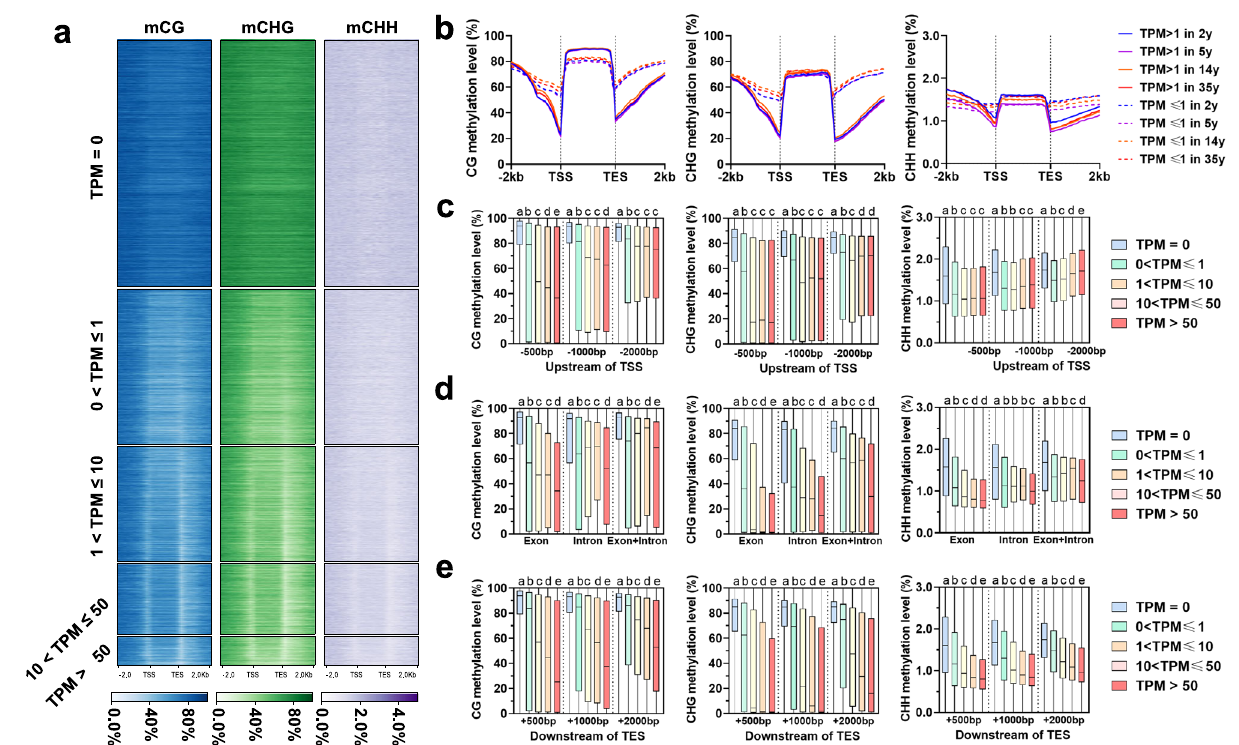
Fig. 2 | Association between DNA methylation and gene expression. a Methylation levels across gene body and fl anking 2kb regions of the fi ve groups ofgenesbasedonexpressionlevels.Thegenebodyandupstreamanddownstream 2kb regions were equally divided into 20 bins for methylation calculation, respectively. b Methylationlevelsacrossgenebodyand fl anking2kbregionsofthe two groups of genes based on expression levelsin each age sample. c Comparison of methylation between fi ve groups of genes based on expression levels for three geneupstreamregions. d Comparisonofmethylationlevelsbetween fi vegroupsof genesbasedonexpressionlevelsforgenicregionsincludingexon,intron,andexon +intron. e Comparison of expression levels between fi ve groups of genes based on